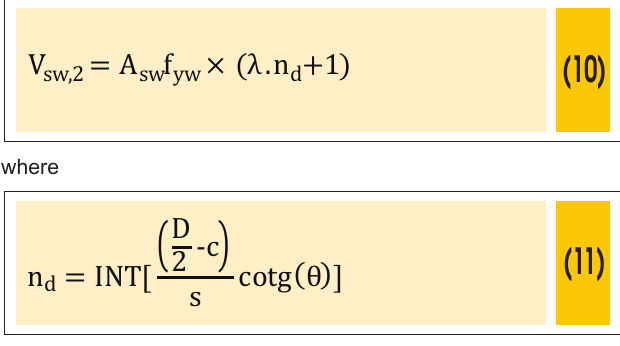
Figure 8 – Example of calculation of the vertical components of the force of stirrups for a circular beam with D = 83.33 cm, d = 0.72 D = 60cm, o 25cm x = c = 3 cm, θ =45 ; circular stirrups, 2 ϕ 10.0 c. 10cm (A =0.8cm ; ρ =0.19%), sw sw following Merta [4]: (a) first and last circular stirrups that crosses the inclined crack o at θ =45 with respect to the beam axis, (b) sum of the contributions of circular stirrups in extension